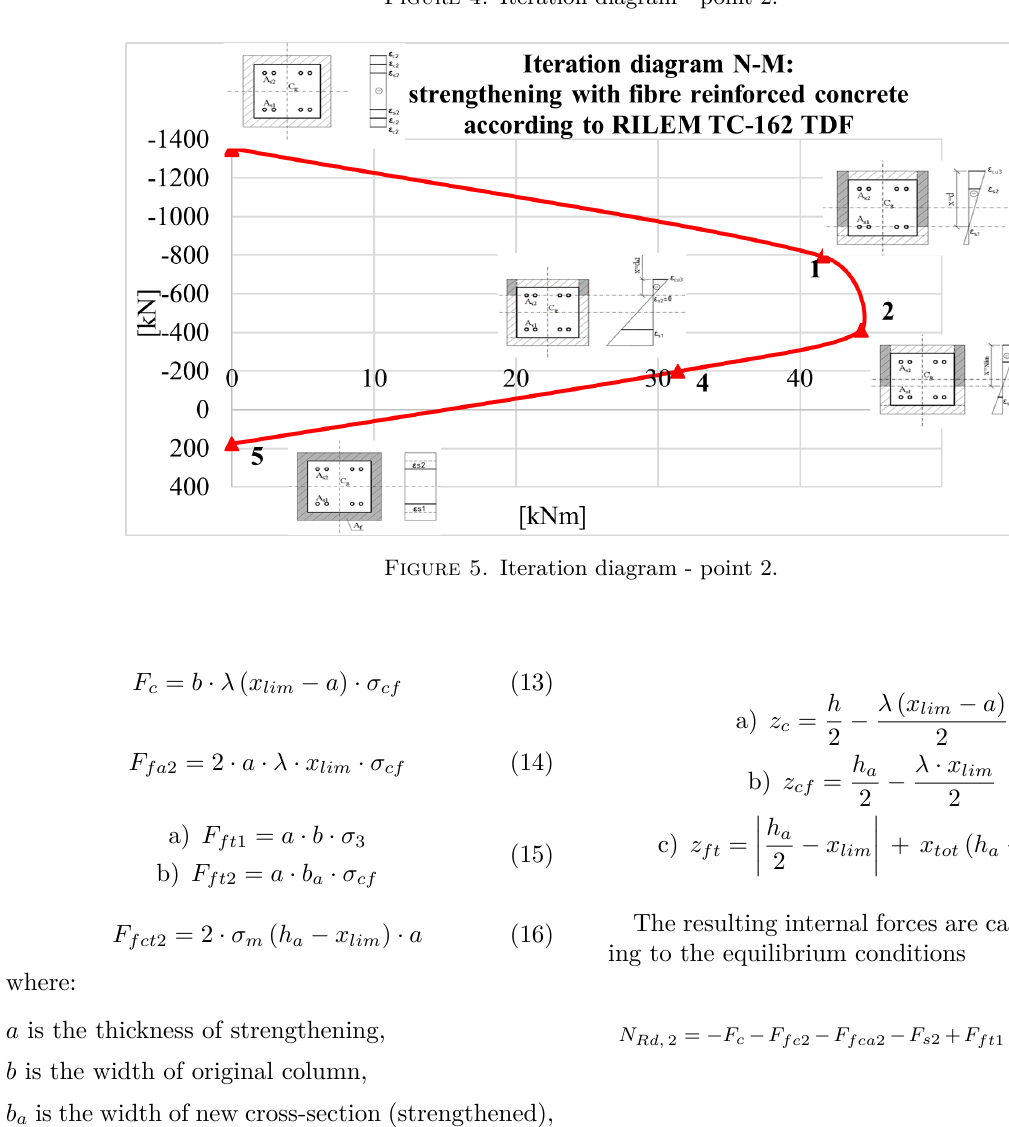
Figure 4. Iteration diagram - point 2.